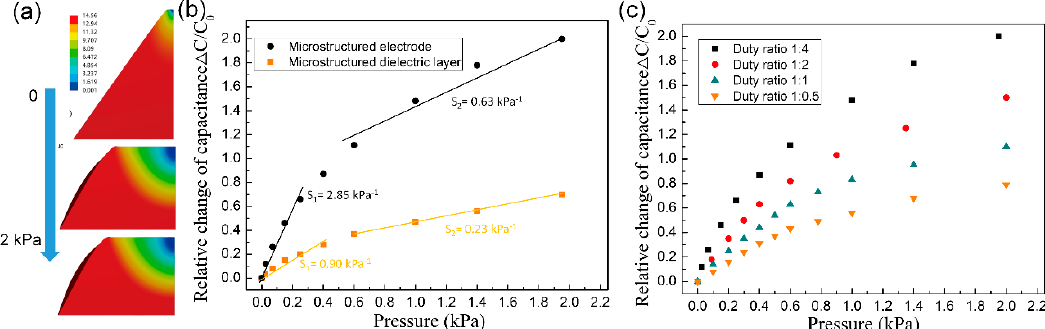
Figure 6. Simulation results of the elastically deform process of the PDMS pyramid ( a ) and sensitivity of a CME and CMD with the same pyramid dimensions ( b ), ( c ) effect of the pyramid density on the sensitivity of CME.